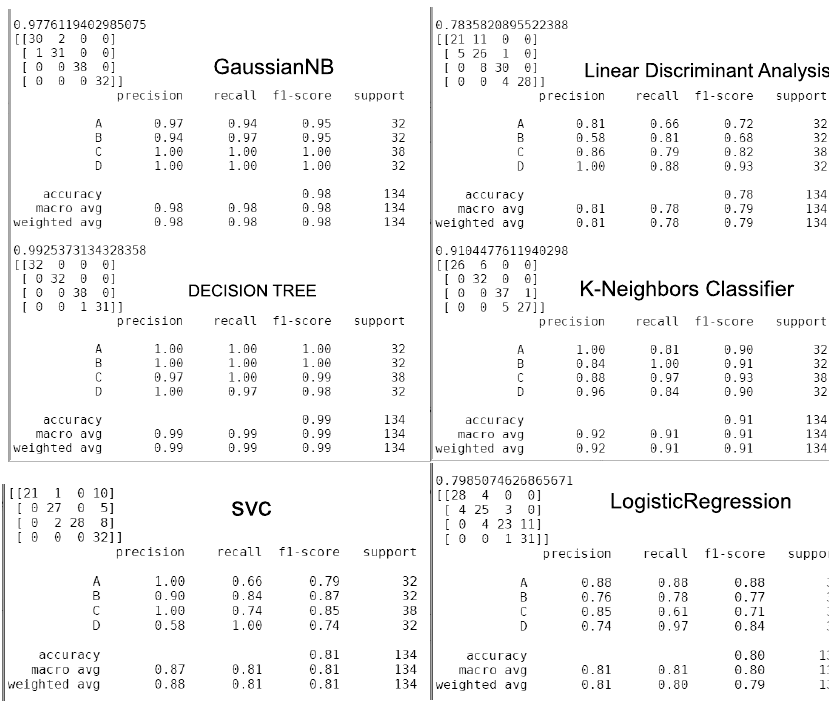
Figure 11. Scatterplot representation of some parameters in the third approach.